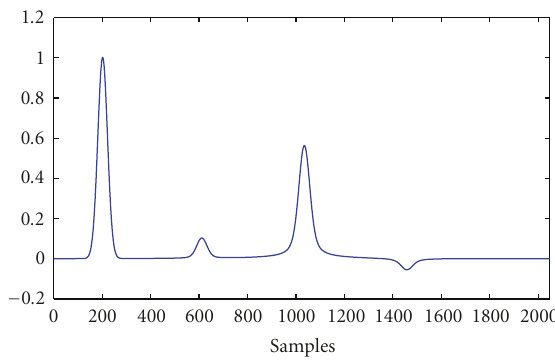
Figure 7: Total signal obtained at the cable entry point